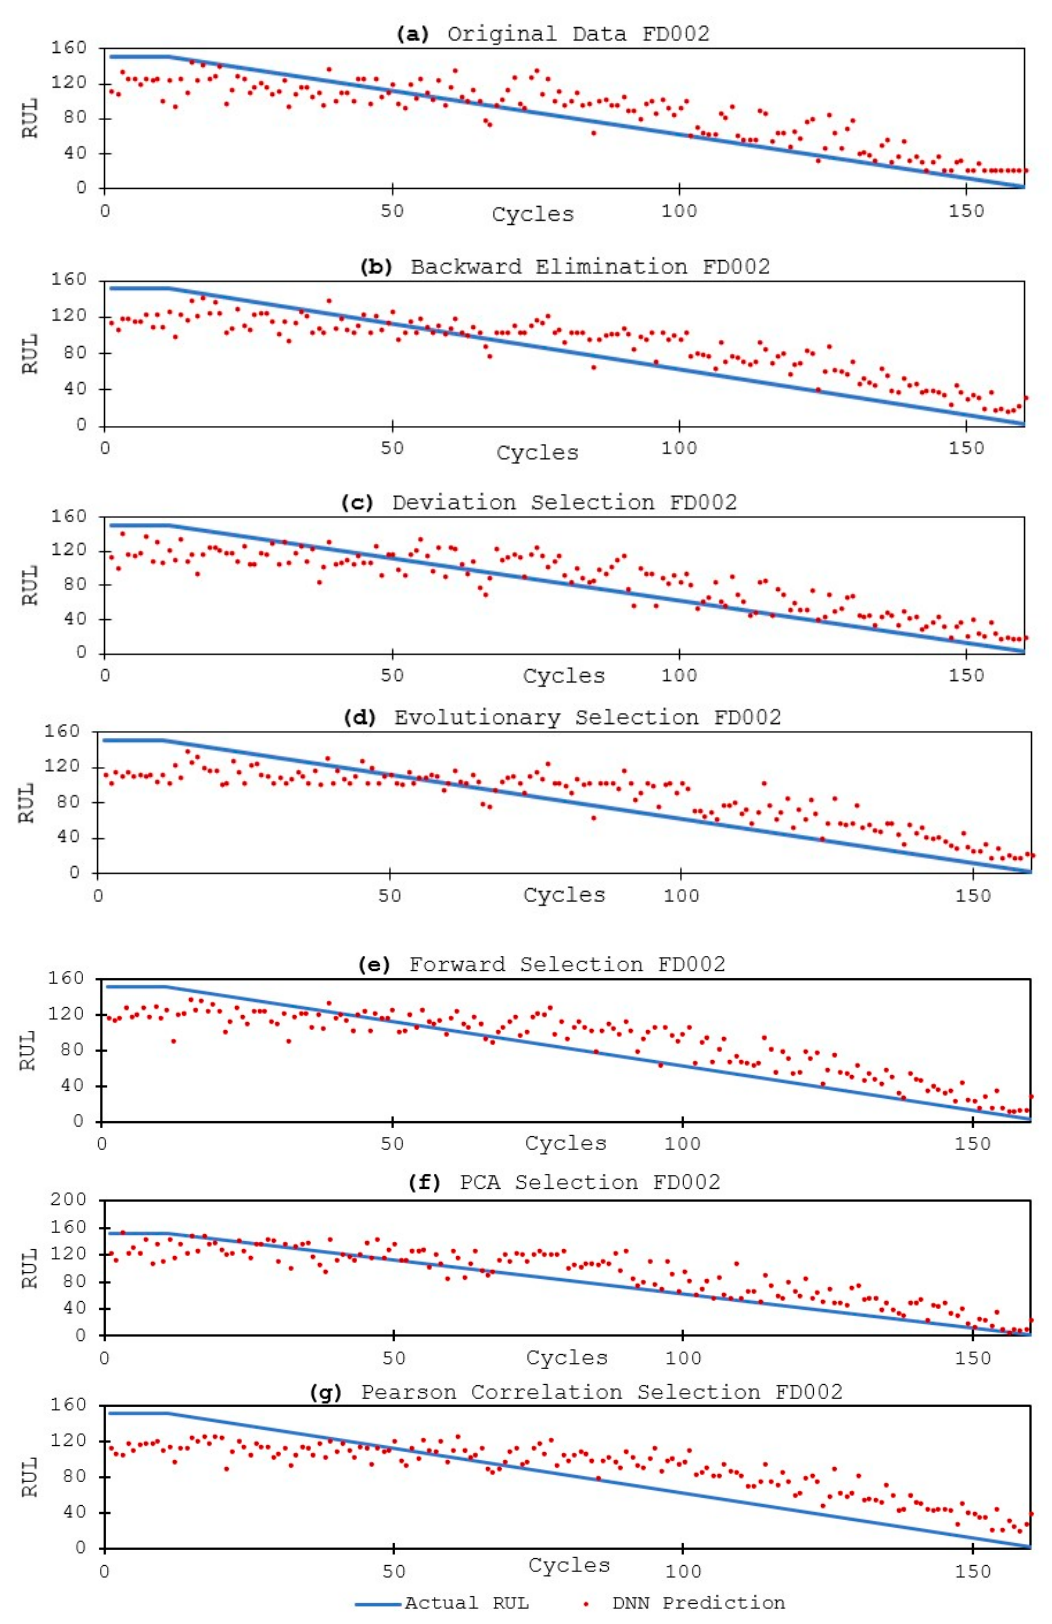
Figure 13. ( a – g ) RUL prediction points for one engine of FD002 test data.